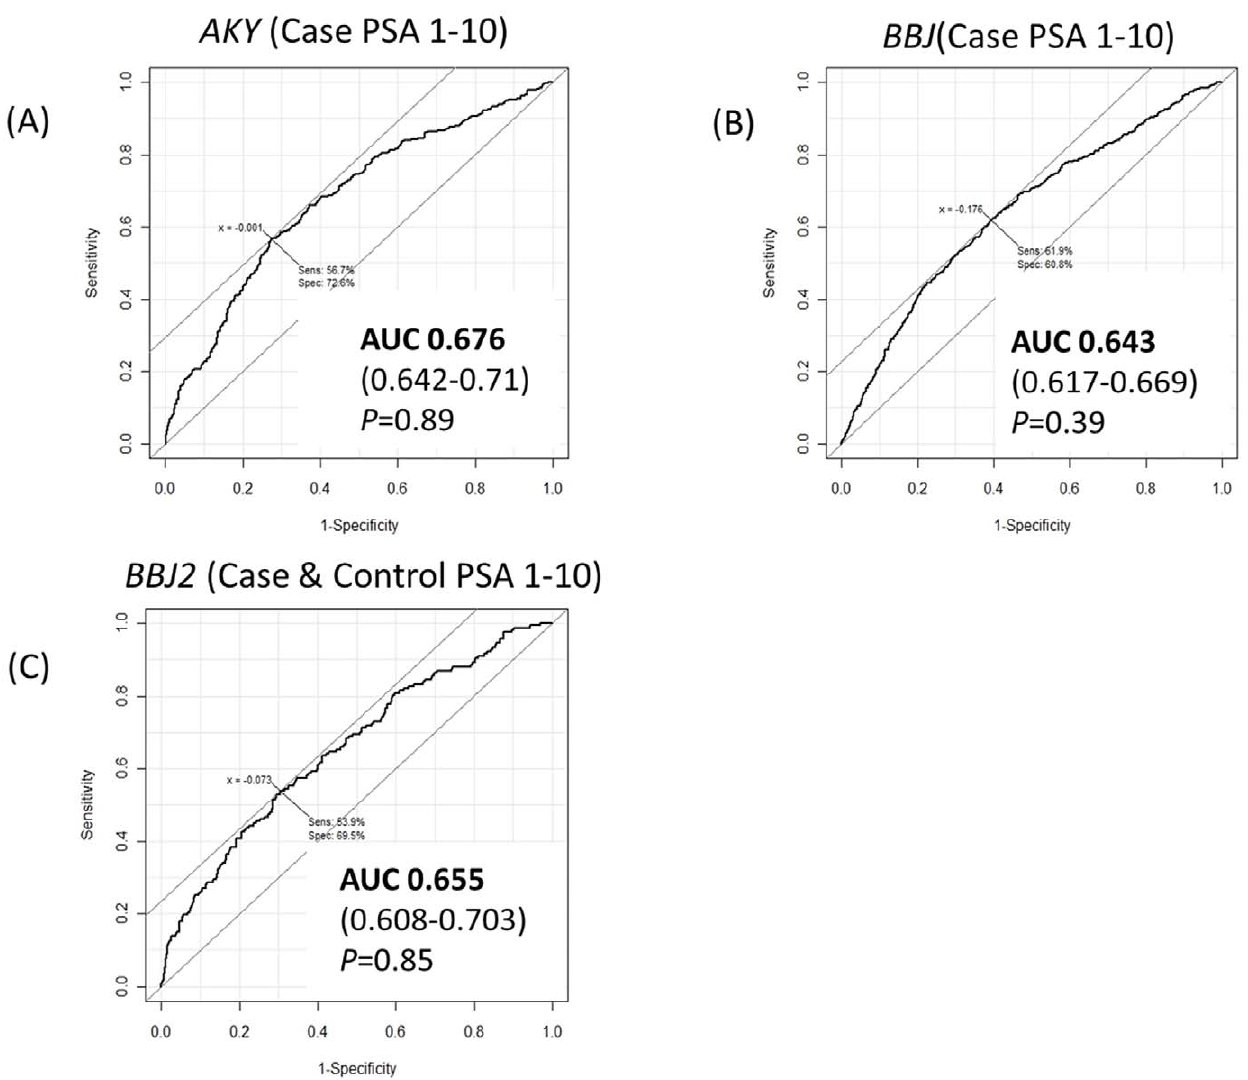
Figure 2. ROC curves of the genetic risk prediction model when the samples were confined to those with PSA 1–10 ng/ml. In (A) AKY and (B) BBJ , case samples with PSA 1–10 ng/ml and all the control samples are used for analysis. In (C) BBJ2 , samples are confined to those with PSA 1–10 ng/ml in both case and control samples. The AUCs of the model and 95% confidence intervals are indicated. In each of the sample sets, the AUCs are statistically compared to the AUCs when serum PSA level is not confined (as shown in Figure 1), and P -values are